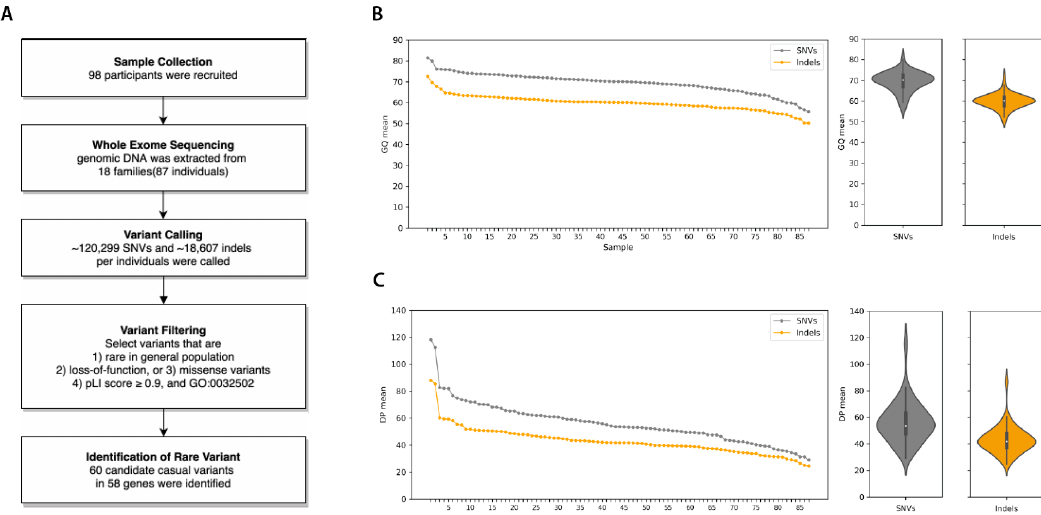
Figure 1. Workflow and quality statistics of familial strabismus exome data. ( A ) Workflow diagram of exome sequence analysis from sample collection to the identification of rare variants in familial strabismus. ( B ) Summary of Genotype Quality (GQ) mean. ( C ) Read Depth (DP) mean per sample. Both quality statistics were measured separately for SNVs (single nucleotide variants) and Indels, for each